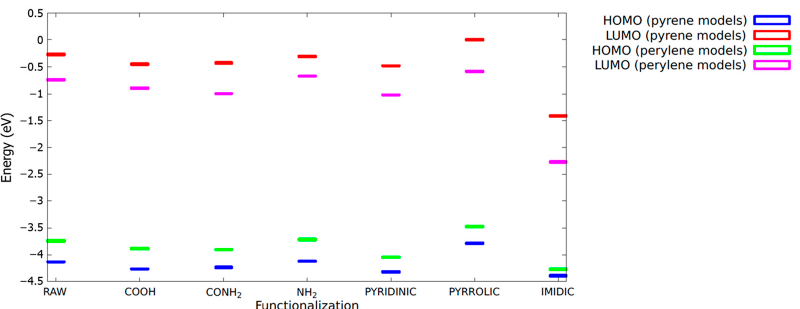
Figure 7. HOMO and LUMO levels for pyrene and perylene models. The reference for the energies (expressed in eV) was chosen as the highest LUMO level, corresponding to the pyrrolic-functionalized pyrene model.